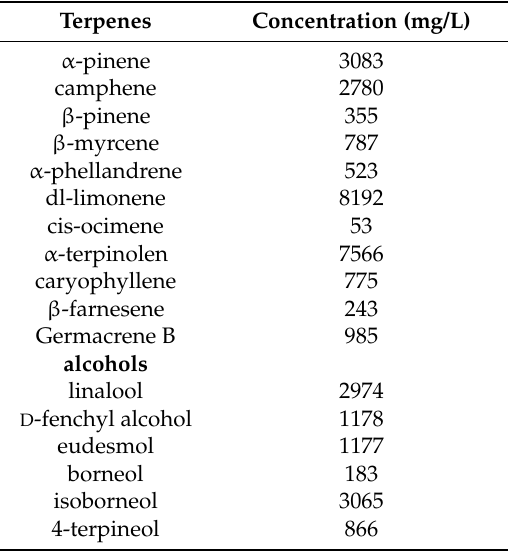
Table 1. Terpenes Concentrations Used for Sensory Analyses.